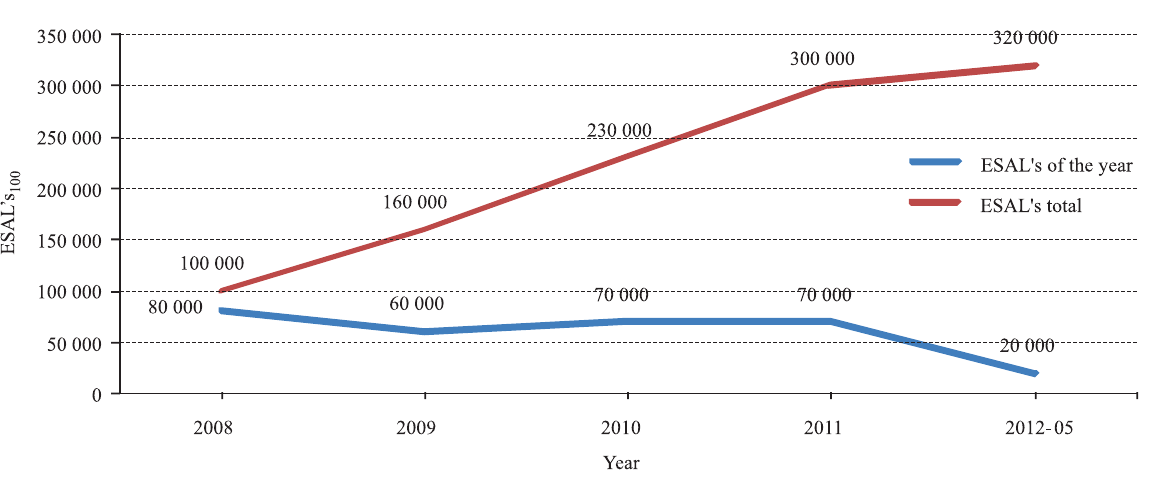
Fig. 3. Distribution of ESAL’s 100 of the experimental pavement